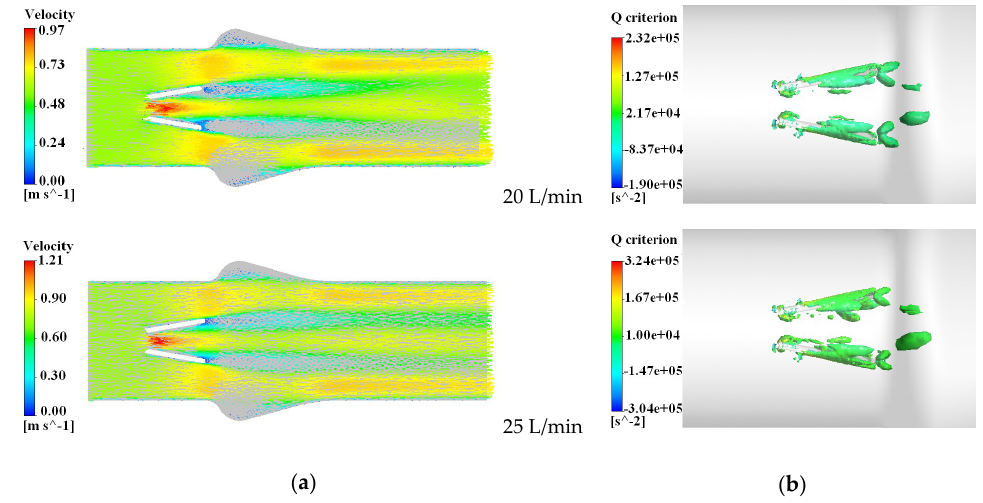
Figure 4. Velocity distribution and Q criterion of vortex core region of the 80 ◦ opening degree bileaflet mechanical heart valve (BMHV). ( a ) Velocity vector distribution and ( b ) Q criterion of vortex core region.